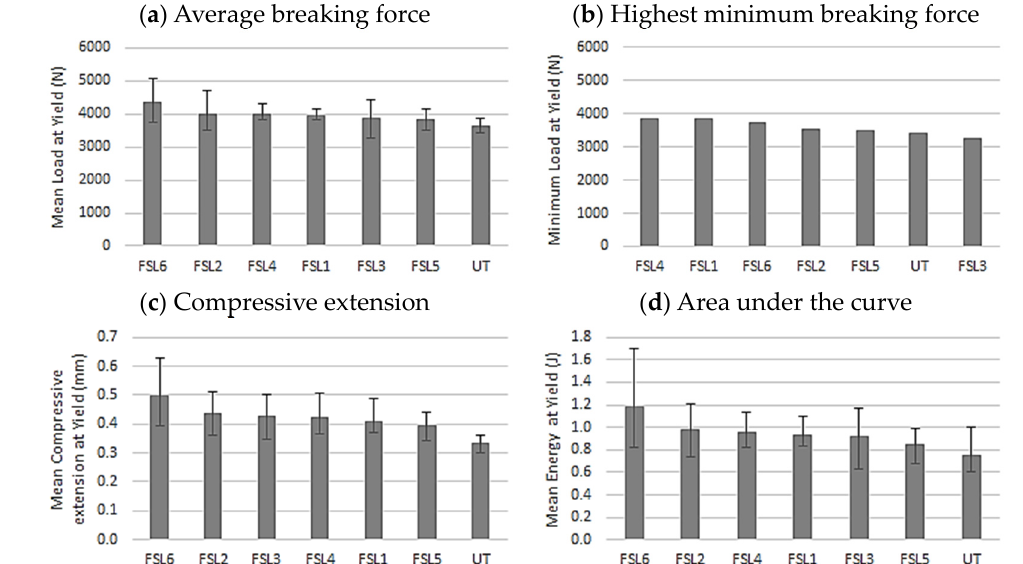
Figure 10. Evaluation of break-out test. Table 6. Summary of break-out test (data for yield